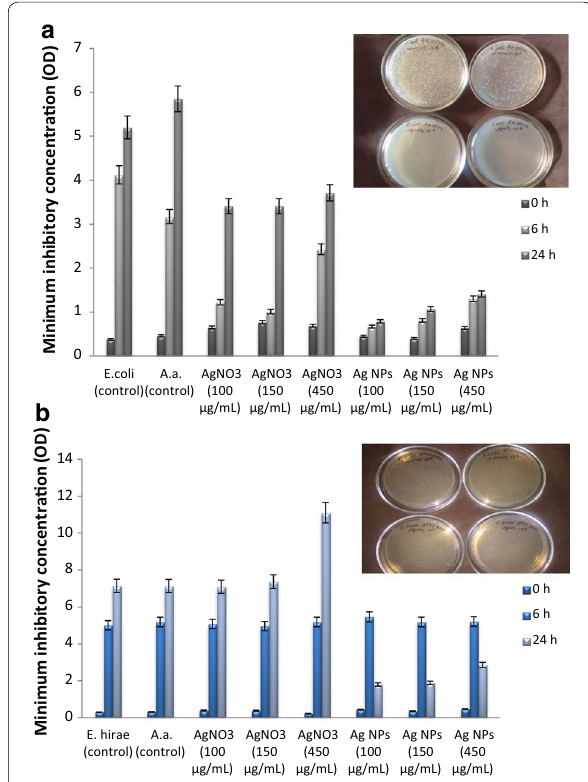
Fig. 7 Antibacterial efficiency of Ag NPs tested on E. coli BW 25113 ( a ) and E. hirae ATCC 9790 ( b ) wild type strains. Ag NPs with concentration from 100 to 450 mg mL − 1 were added into the bacterial growth medium. Data value was compared with the corresponding control value (p ≤